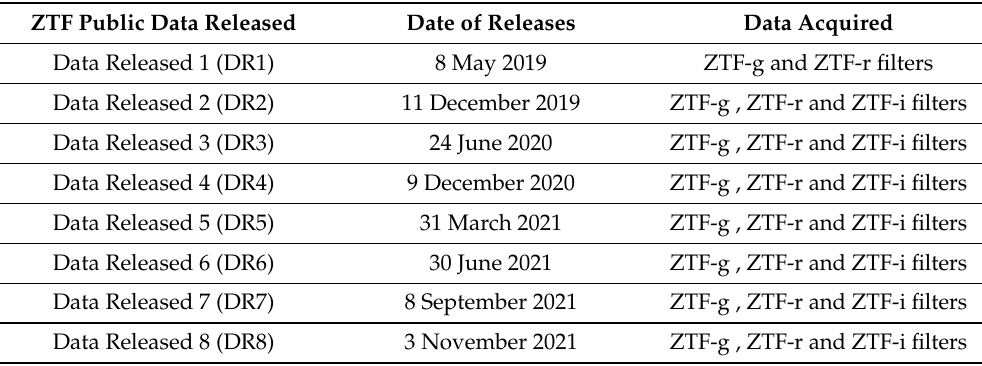
Table 3. ZTF science data